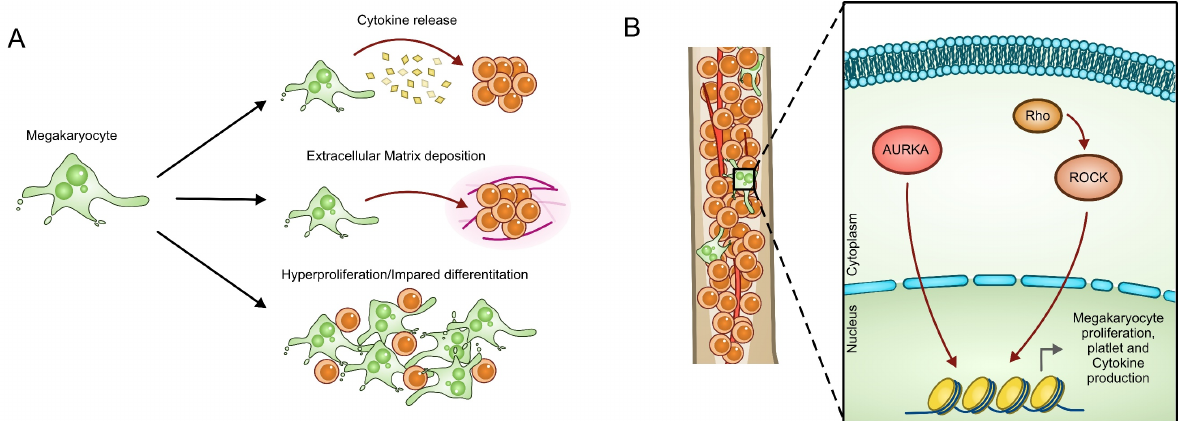
Figure 4. Megakaryocyte role in MPN progression and drug resistance. ( A ) Megakaryocytes play different roles in sustaining MPN cell malignancy. Abnormal megakaryocyte differentiation and functionality are considered responsible for cytokine release and extracellular matrix deposition in myelofibrosis. Hyperproliferation and alteration in megakaryocyte morphology are common features in MPNs. ( B ) These aberrant functions are sustained through the hyperactivation of Aurora kinase A (AURKA) and ROCK pathways in megakaryocytes.